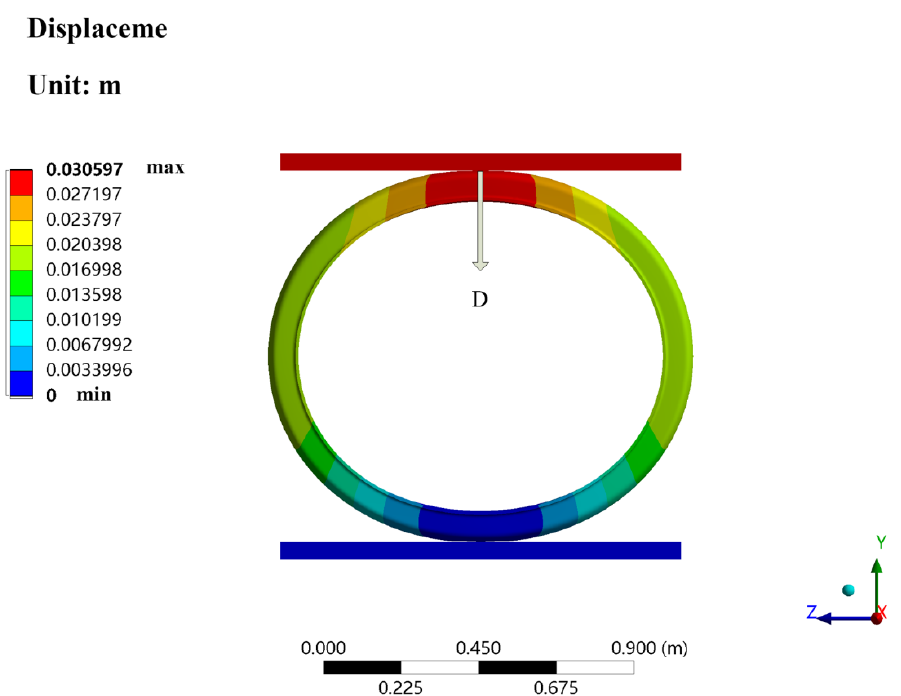
Figure 12. The displacement distribution of a bellows. The diameter of the bellows is 1000 mm.